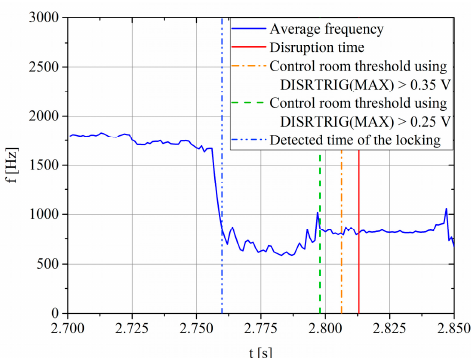
Figure 7. Plot for the pulse 36112. In blue the estimator in (6) for the frequency of the modes. Vertical lines stand for the time instances at which the different estimators considered have triggered an alarm and in red the time instance at which the disruption occurred. In dashed blue, the time instance provided by (8), in dashed green the one used in the control room (CR) at AUG to start mitigation actions (at 0.25 V) and in dashed orange the mitigation valve opening trigger (at 0.35 V).